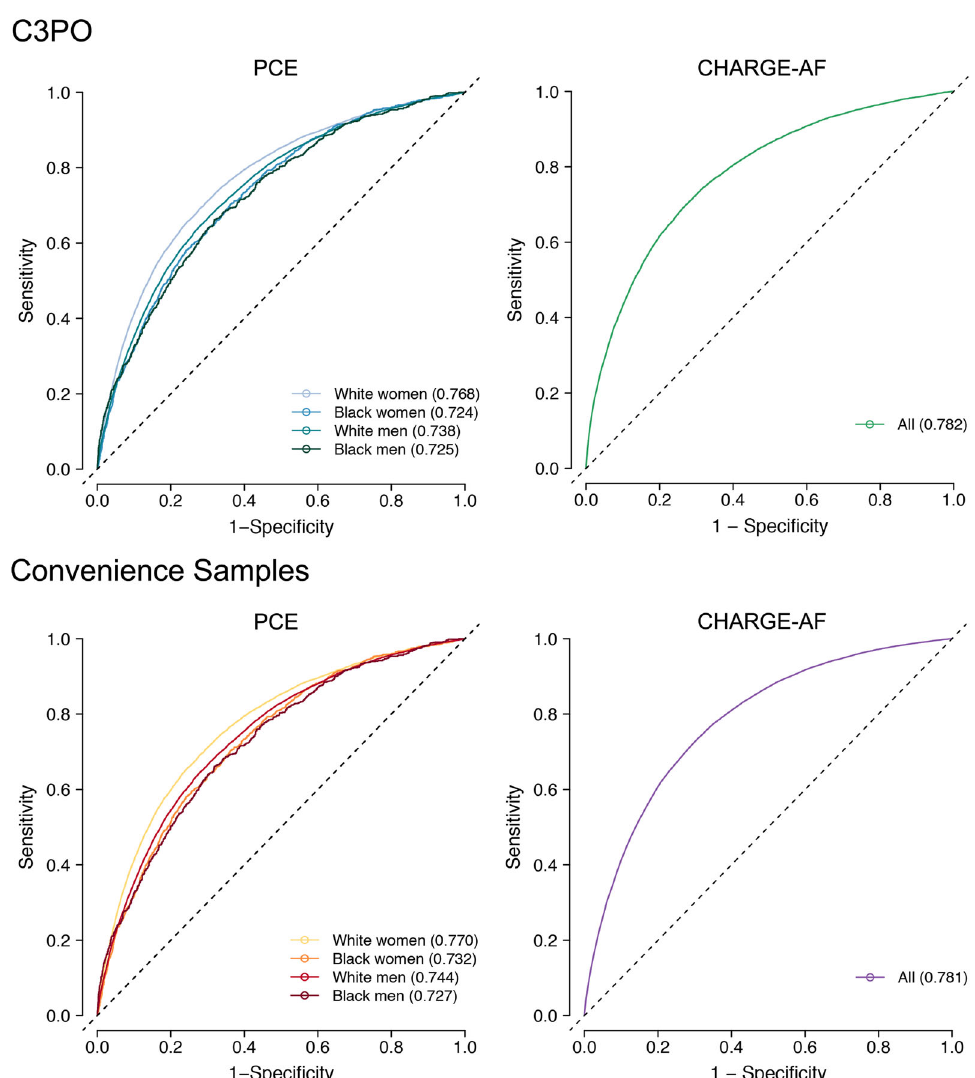
Fig. 6 Model discrimination in C3PO and Convenience Samples. Depicted are time-dependent receiver operating characteristic curves for the Pooled Cohort Equations (PCE, left panels) and the CHARGE-AF score (right panels) in C3PO (top panels) versus the respective Convenience Samples (bottom panels). Each plot shows the discrimination performance of each risk score for its respective prediction target (i.e., 10-year MI/stroke for the PCE, 5-year incident AF for CHARGE-AF). Since the PCE score comprises four models strati fi ed on the basis of sex and race, the curves for each score are represented separately (see legend). The c-index calculated using the inverse probability of censoring weighting method 28 is depicted for each